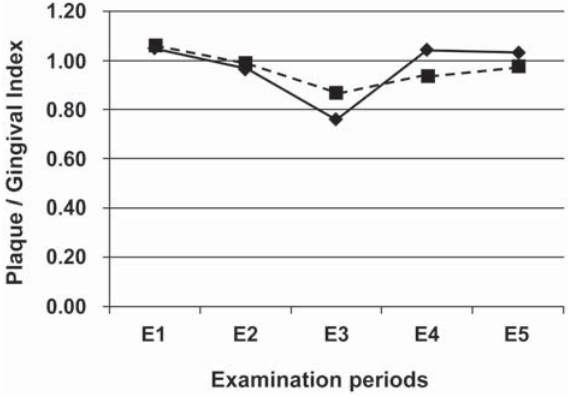
Figure 4- Alterations of plaque index (PI: solid line) and gingival index (GI: broken line), respectively